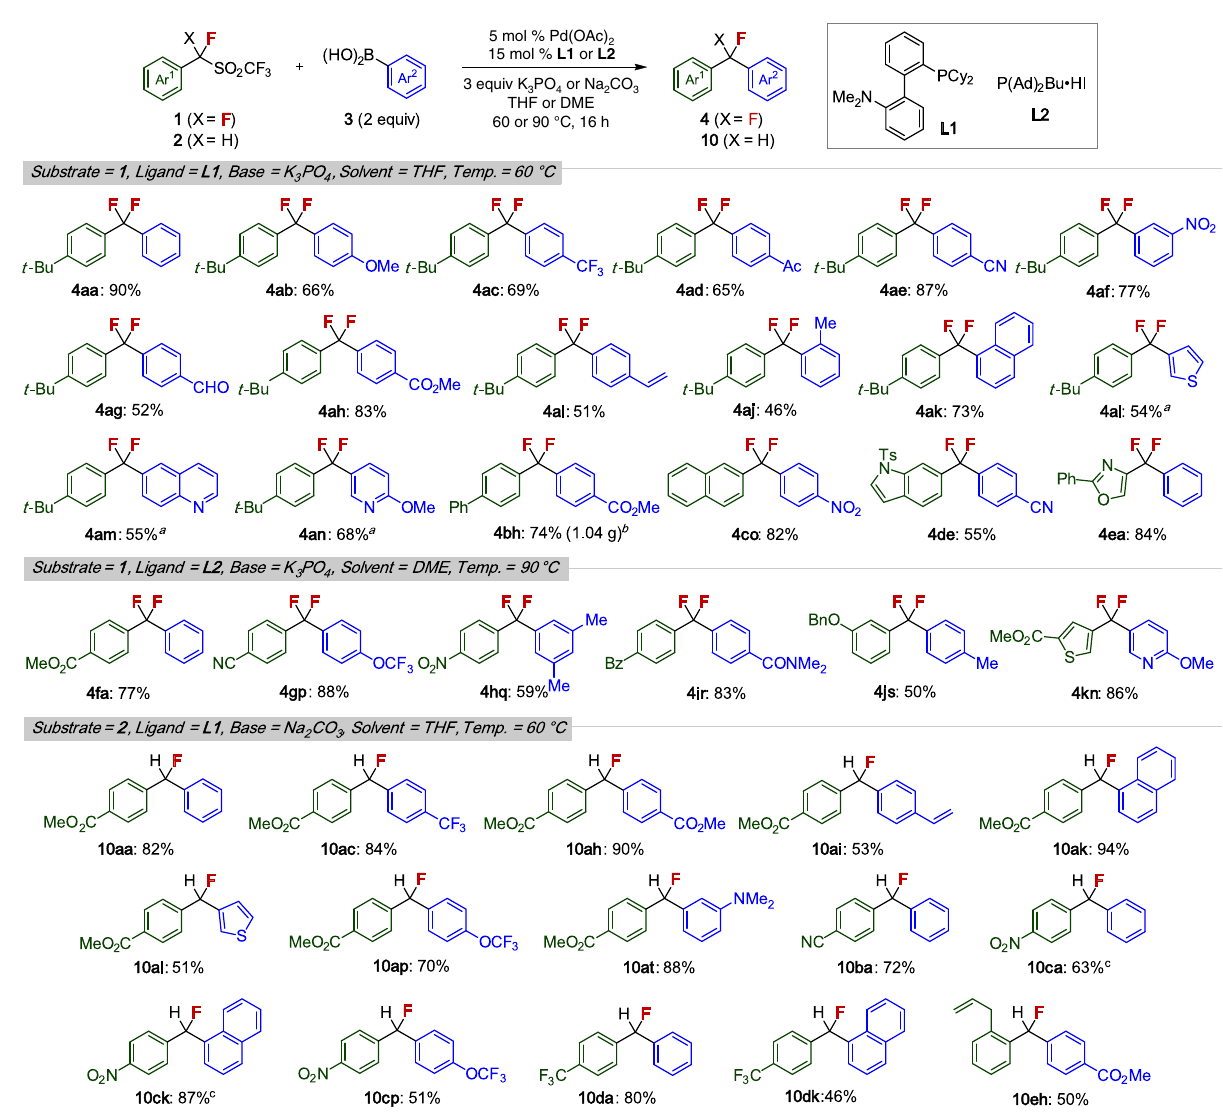
Fig. 3 Substrate scope of desulfonylative Suzuki − Miyaura cross-coupling of 1 and 2. Reactions were carried out on 0.15-0.3 mmol scale; isolated yields. a 10 mol % (Pd(OAc) 2 and 30 mol % DavePhos were used. Reaction conducted in DME at 90 °C.